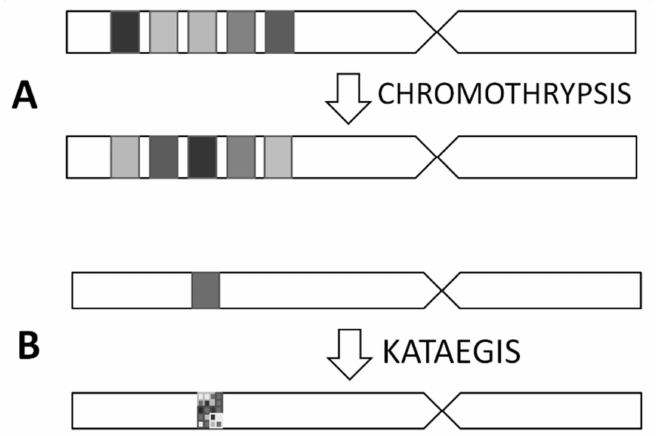
Figure 2. Schematic representation of changes after chromothripsis (Panel A ) and kataegis (Panel B ). The occurrence of chromothripsis results in a new configuration in the part of a chromosome. Kataegis describes a hypermutation pattern located in one or multiple loci in the